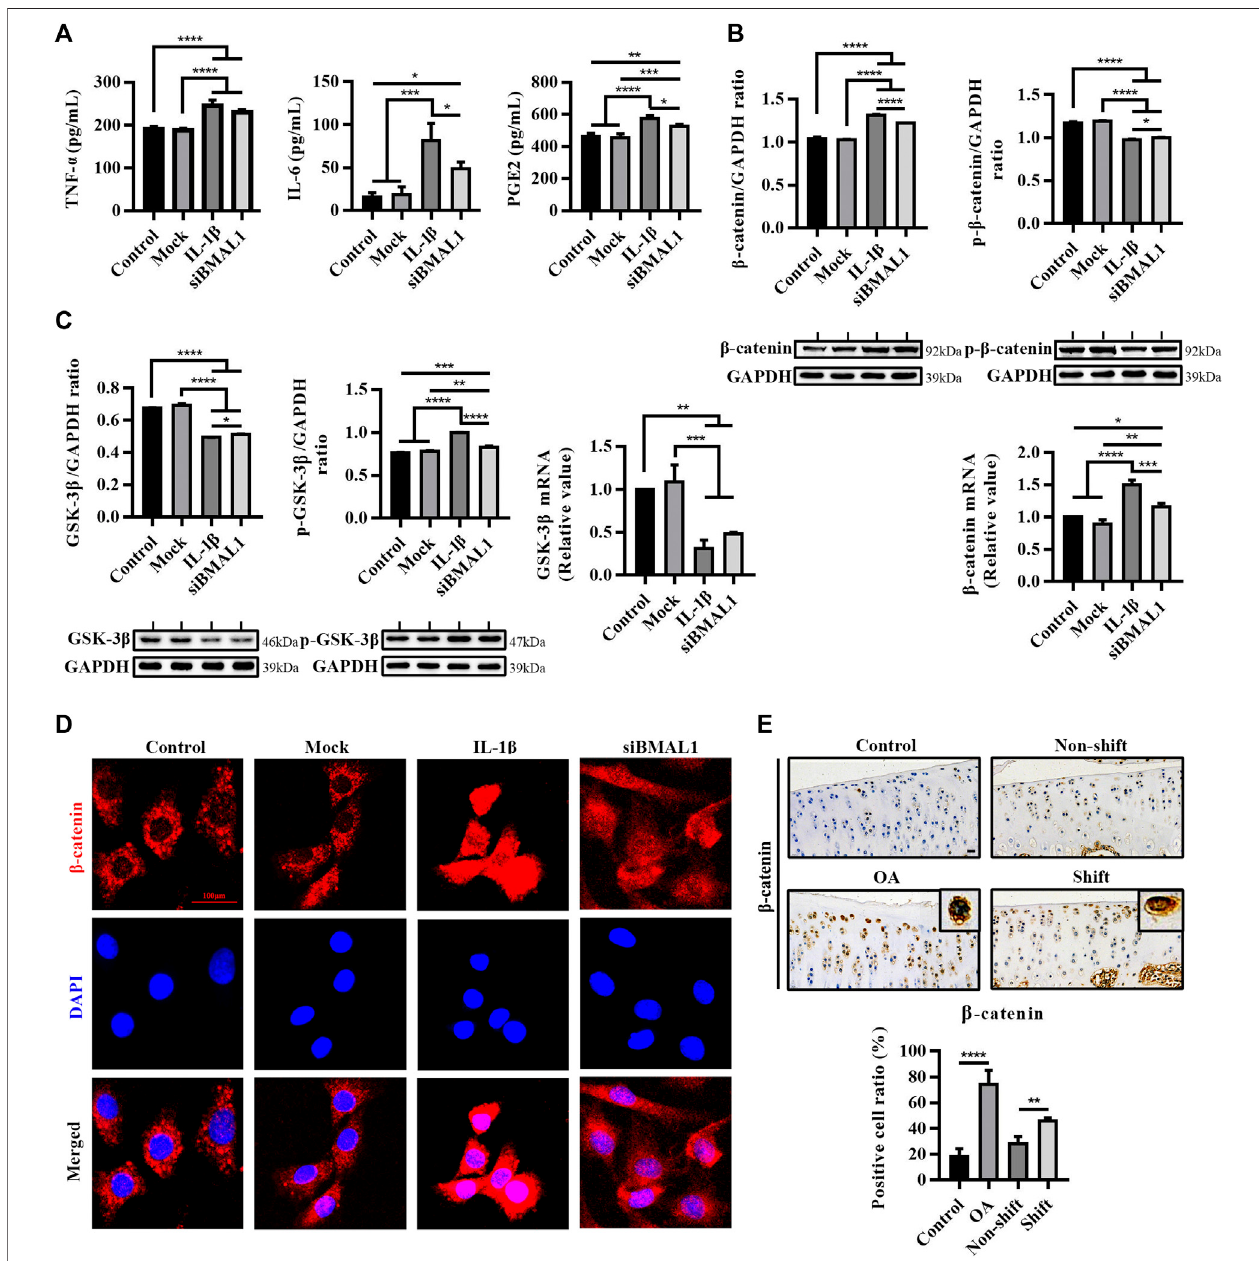
FIGURE3| In fl ammatoryresponseandactivationoftheWNT/ β -cateninpathway invitro chondrocytesstimulatedbyIL-1 β andsiBMAL1. (A) LevelsofTNF- α ,IL-6, and PGE2 in ECS. Results are expressed as mean ± SEM; n (cid:2) 3 – 4. (B) Protein expression changes of β -catenin and p- β -catenin, and mRNA levels of β -catenin in chondrocytes ineach group. Allexperiments wereperformed intriplicate, and theresultsare expressed asthemean ± SEM. (C) ProteinexpressionchangesofGSK-3 β and p-GSK-3 β , and mRNA levels of GSK-3 β in chondrocytes in each group. All experiments were performed in triplicate, and the results are expressed as the mean ± SEM. (D) Nuclear translocation of β -catenin in chondrocytes stimulated with IL-1 β and transfected with siBMAL1. β -catenin was highly expressed in the cytoplasmofcontrolchondrocytes,yetmostlytransferredintothenucleusafterIL-1 β stimulation.Aconsiderablenumberof β -cateninproteinwerealsotransferredtothe nucleus in KD-BMAL1 chondrocytes. Mag, 400 × . Scale bar, 100 μ m. (E) Expression changes of β -catenin in tibial plateau cartilage of rats in each group. Mag, 200 × . Scale bar, 50 μ m. Results are expressed as mean ± SD; n (cid:2) 4. * p < 0.05, ** p < 0.01, *** p < 0.001, and **** p < 0.0001.